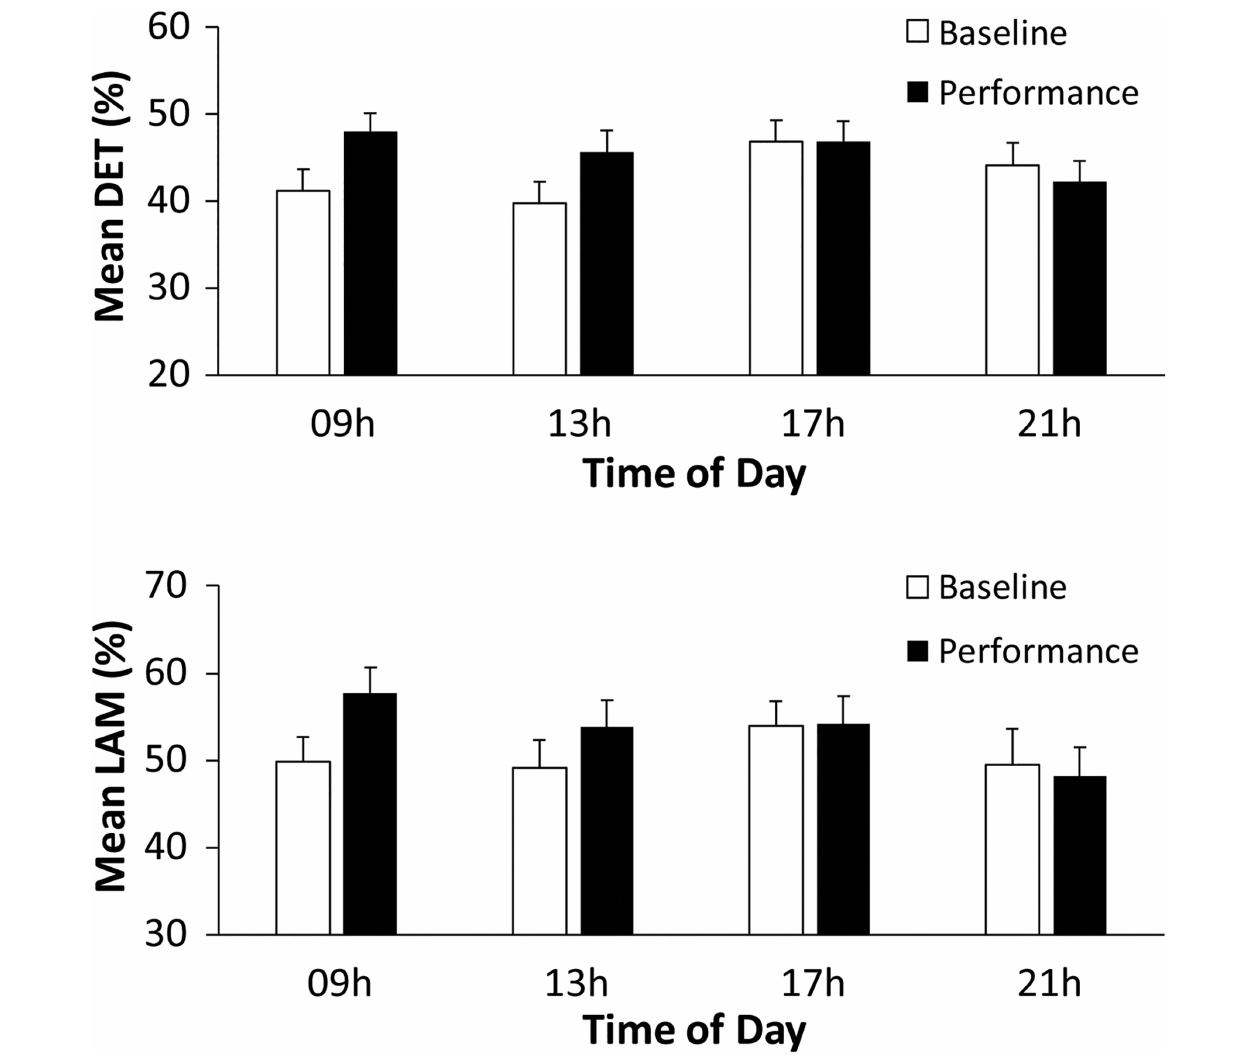
FIGURE 5 | Performers’ mean% Determinism (top) and mean% Laminarity (bottom) , by Time of Day and Task (Baseline rest/Music